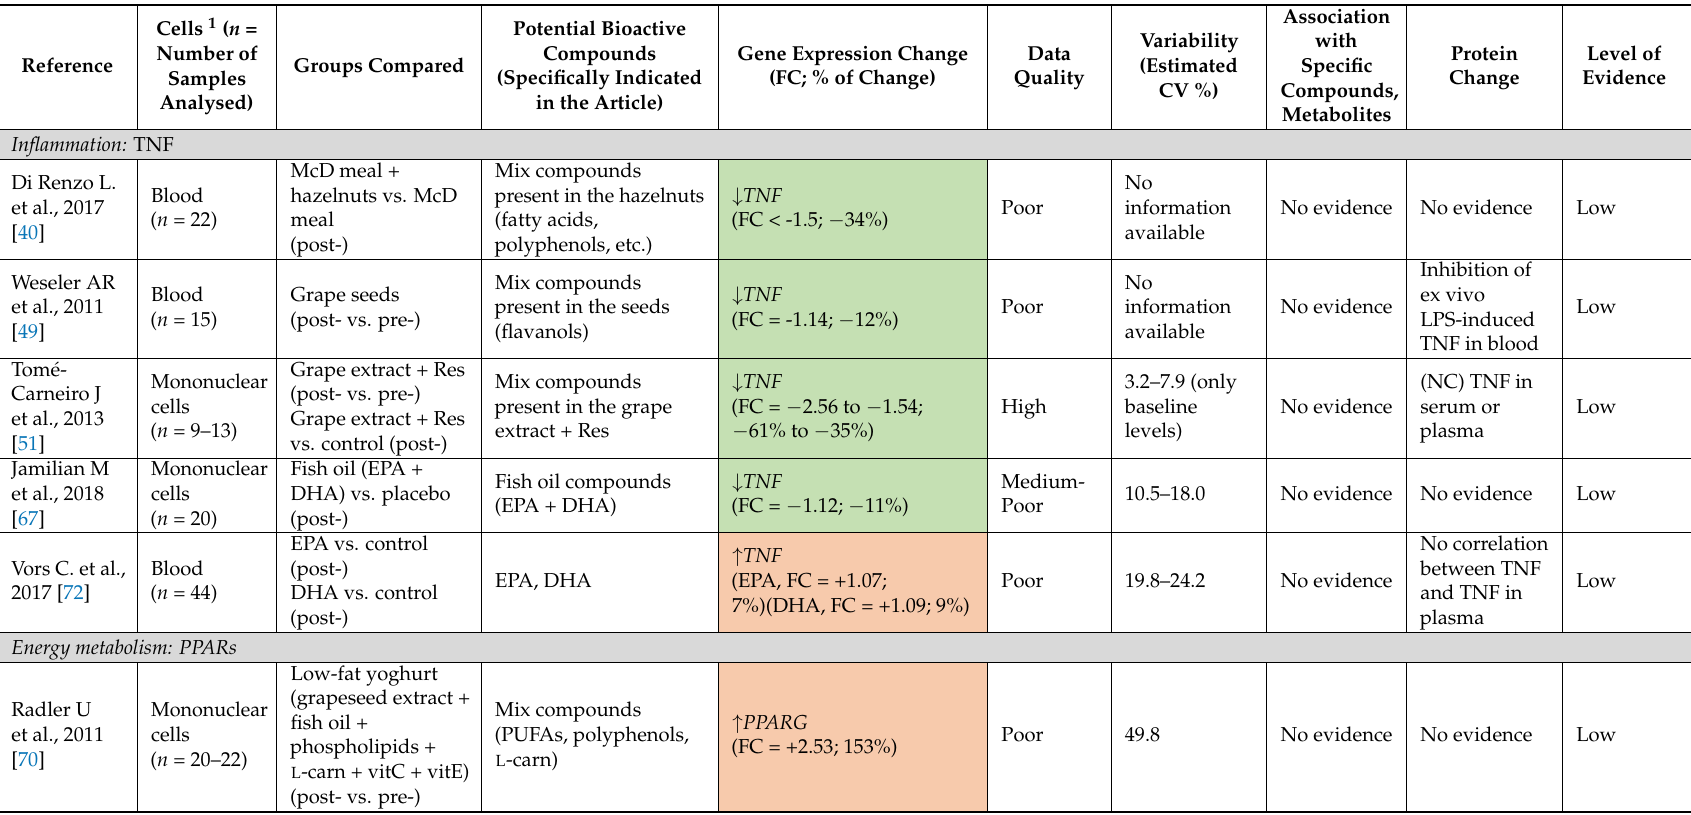
Table 3. Overview of the significant expression changes reported for specific gene targets in different cells and tissue samples following intervention with diet, foods, or derived products containing bioactive compounds. Analysis of the evidence supporting the changes and, the potentiality of these changes as a mechanism of action underlying the beneficial effects attributed to these products and bioactive compounds ( p - value <